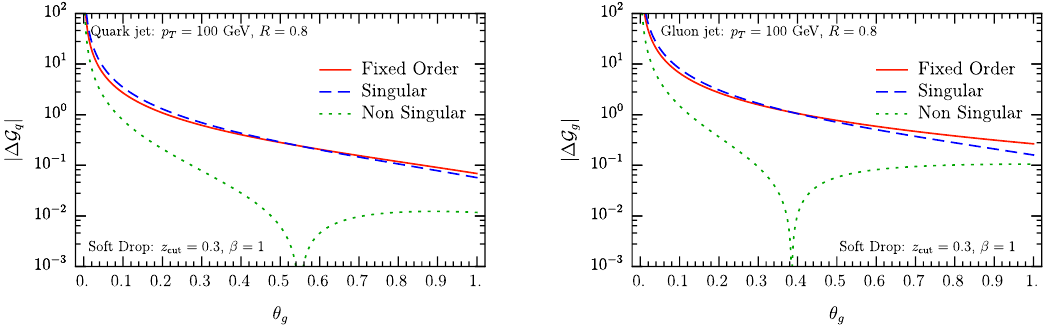
Figure 10 . Numerical results for the singular, non-singular and fixed-order result of ∆ G SD drop as a function of the groomed jet radius θ g , for the same jet kinematics as in figure 3 and with grooming parameters β = 1 and z cut = 0 . 3